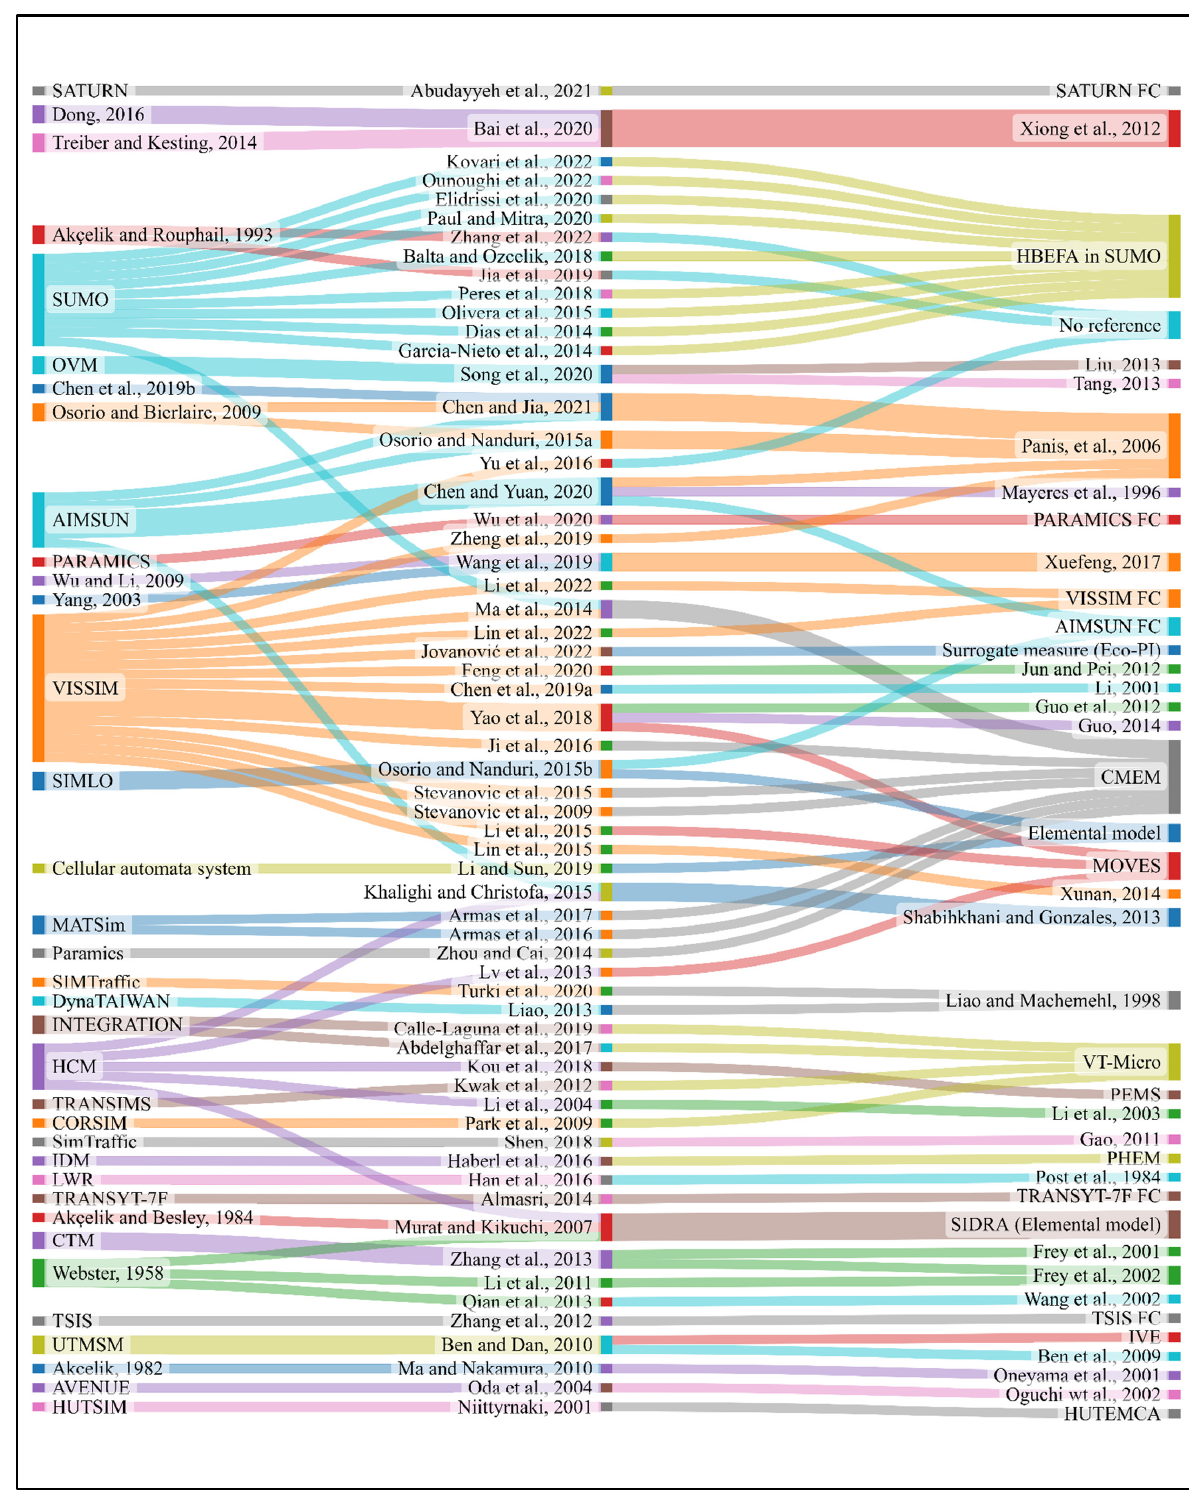
Figure 3. Connections between studies, traffic programs, and fuel consumption/emissions models. Akçelik and Rouphail, 1993 [28], VISSIM [30], SUMO [31], AIMSUN [32], SATURN [36], Osorio and Bierlaire, 2009 [37], Chen et al., 2019b [38], Dong, 2016 [39], Treiber and Kesting, 2014 [40], OVM [41,42], SIMTraffic [43], PARAMICS [44], INTEGRATION [45], Cellular automata system [46], Wu and Li, 2009 [47], Yang, 2003 [48], HCM [29], MATSim [49], IDM [50], LWR [51], SIMLO [52], TRANSYT-7F [53,54], DynaTAIWAN [55], Webster, 1958 [12], CTM [56,57], TRANSIMS [58], TSIS